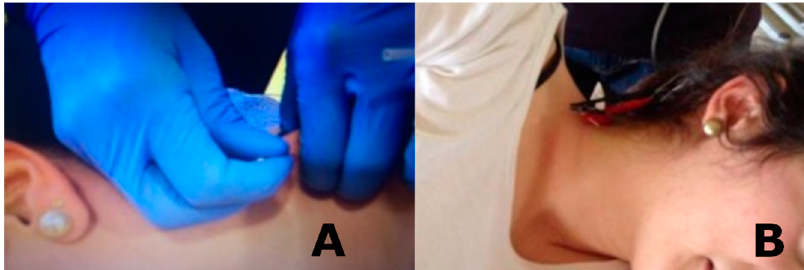
Figure 1. Applied interventions: ( A ) dry needling and ( B ) percutaneous electrical nerve stimulation.